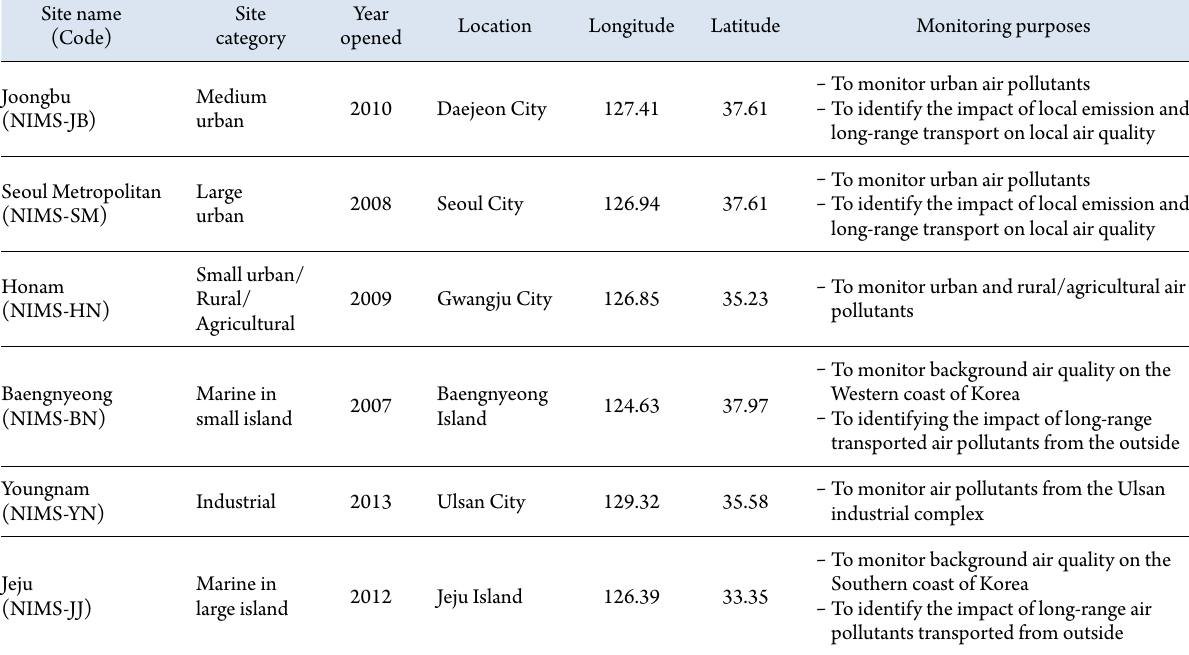
Table 1. NIMS information in Korea (NIER,